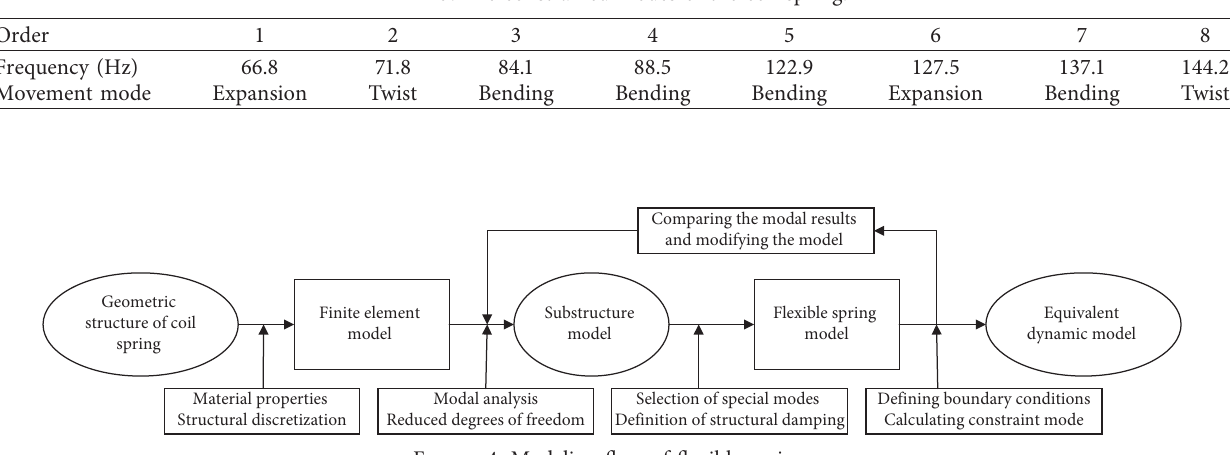
Figure 4: Modeling flow of flexible spring.